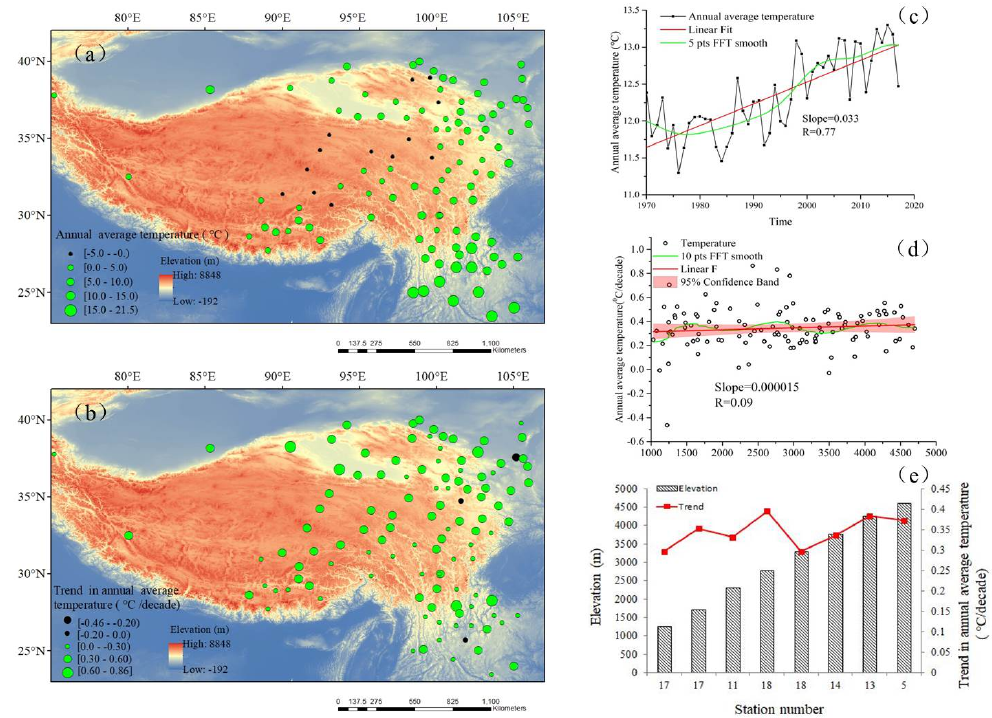
Figure 11. Spatial distribution of the averaged and long-term climatological trends in annual mean temperature ( a ) and ( b ), changes in annual mean temperature ( c ), scatter plots of trends (°C/decade) by elevation for annual mean temperature ( d ) and elevation dependence of annual mean temperature trends (°C/decade) ( e ) in the TP and TPS during1971–2017. (The numbers in horizontal axis in e represent the stations in each 500 m elevation band, and trend magnitude is plotted on the y axis).